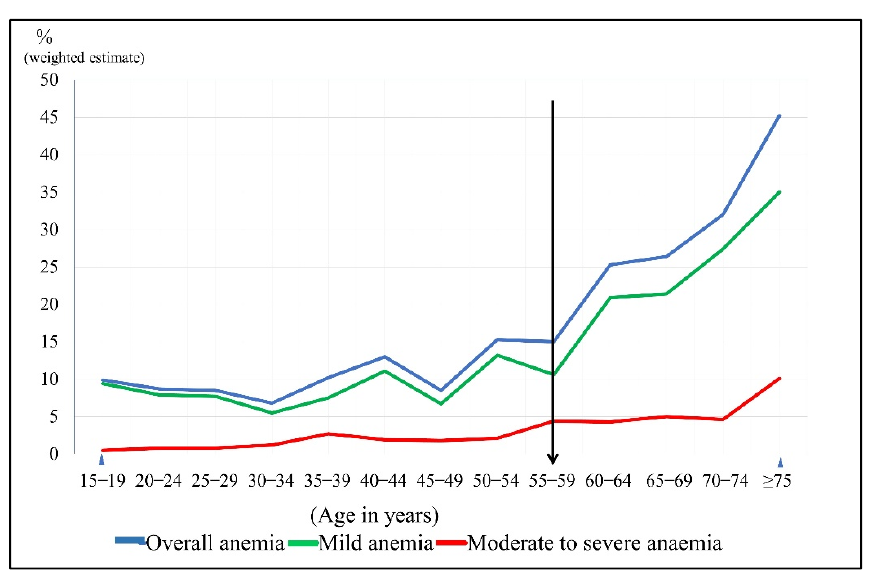
Figure 1. The trends of anemia’s prevalence according to the level of severity using a 5-year age interval among men in Malaysia.